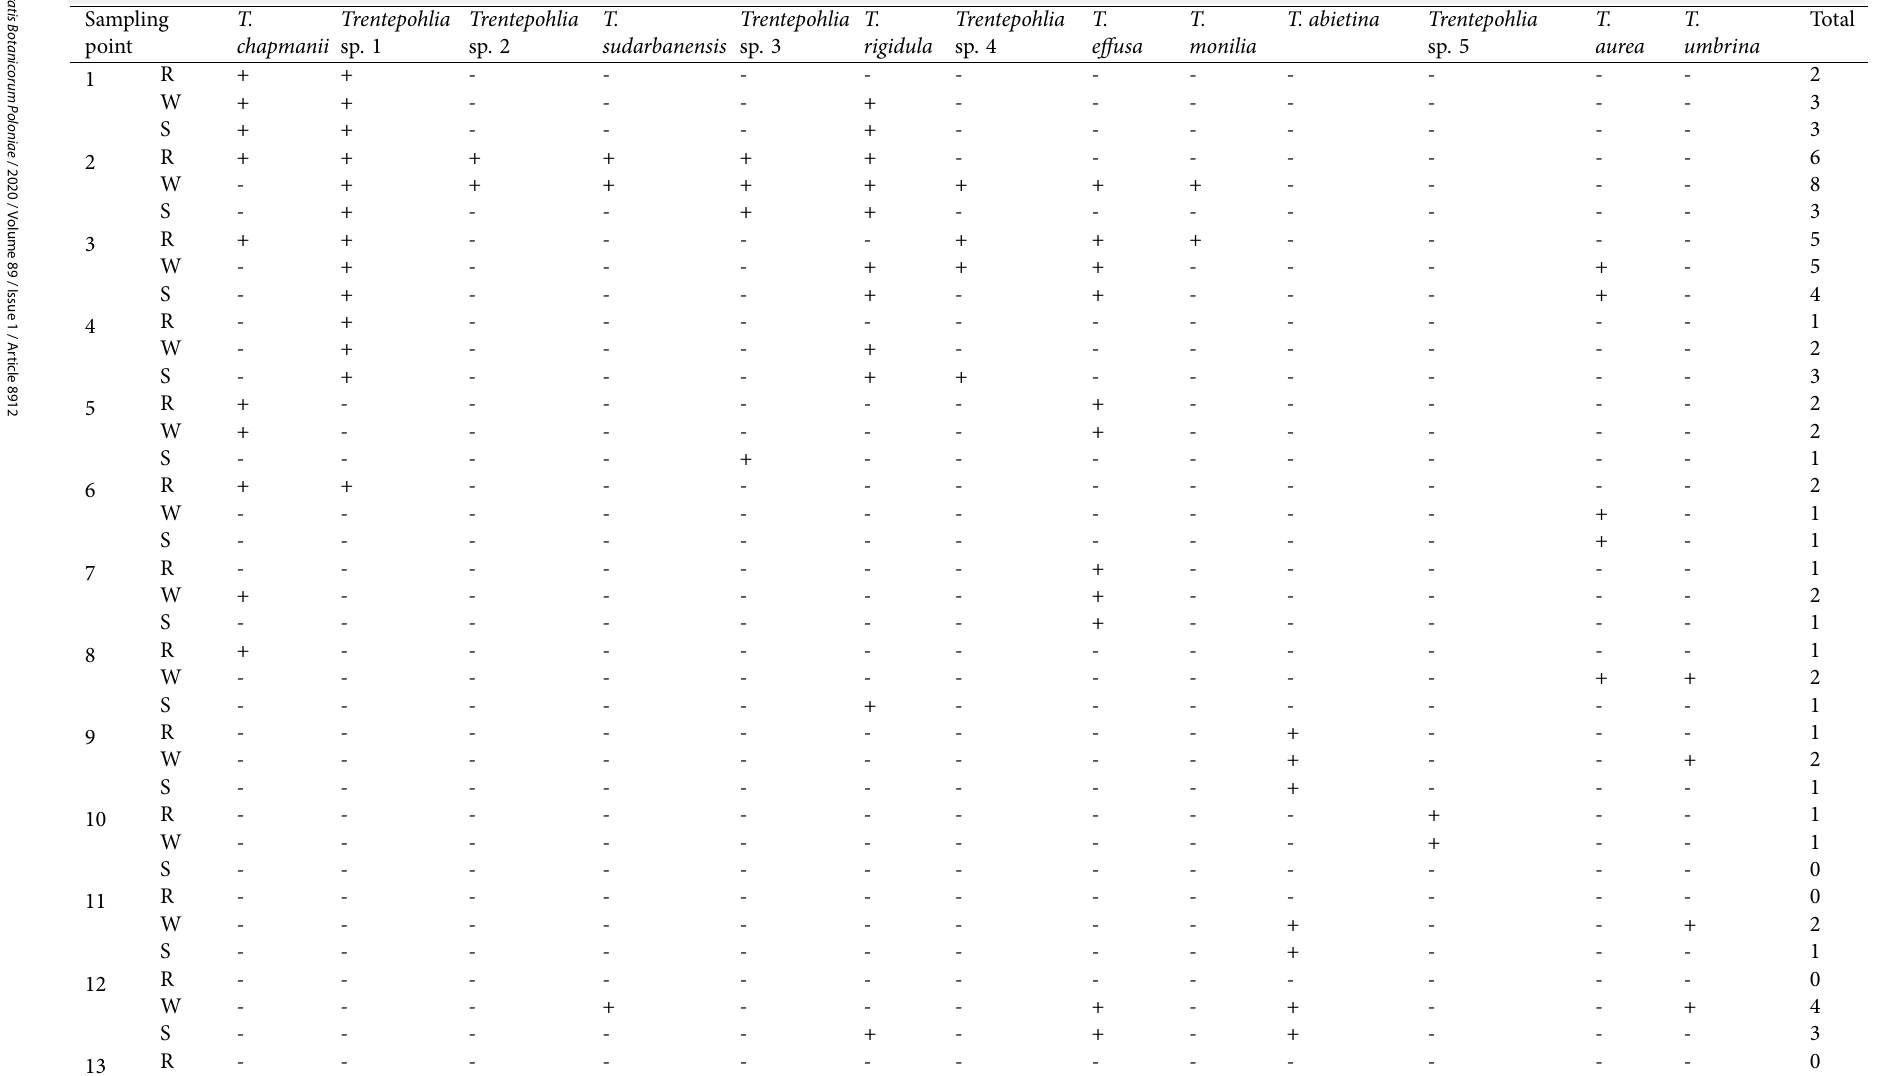
Table 1 Diversity and composition of the subaerial green algae genus Trentepohlia at 13 sampling points during the rainy, winter, and summer seasons.